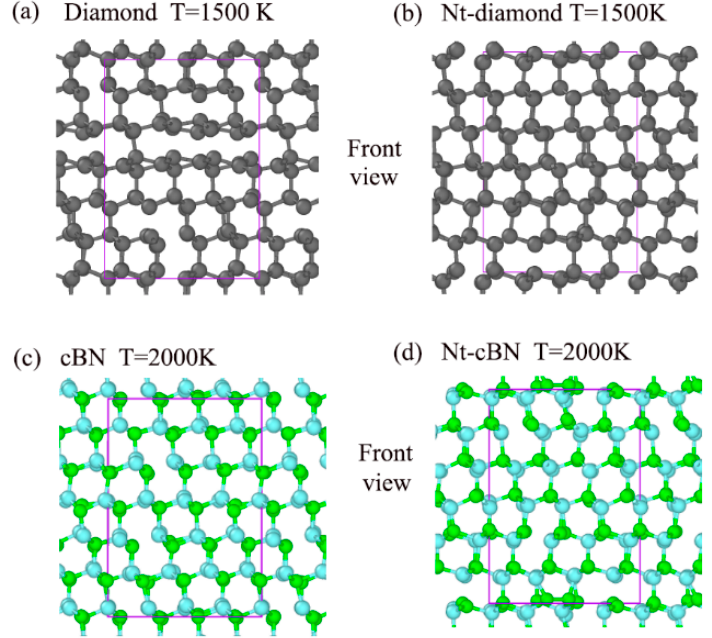
Figure 2. ( a ) and ( b ) are snapshots of ab initio molecular dynamics simulations depicting structural changes in diamond and nt-diamond at T = 1500 K. Corresponding snapshots of cBN and nt-cBN at T = 2000 K are shown in ( c ) and ( d ). The solid purple line represents unit cell.